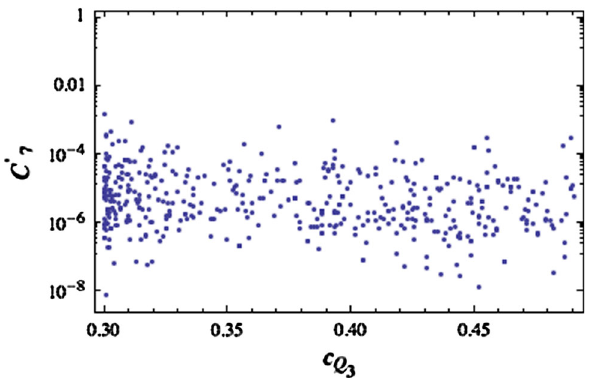
Fig. 3 C (cid:7) as a function of c Q 7